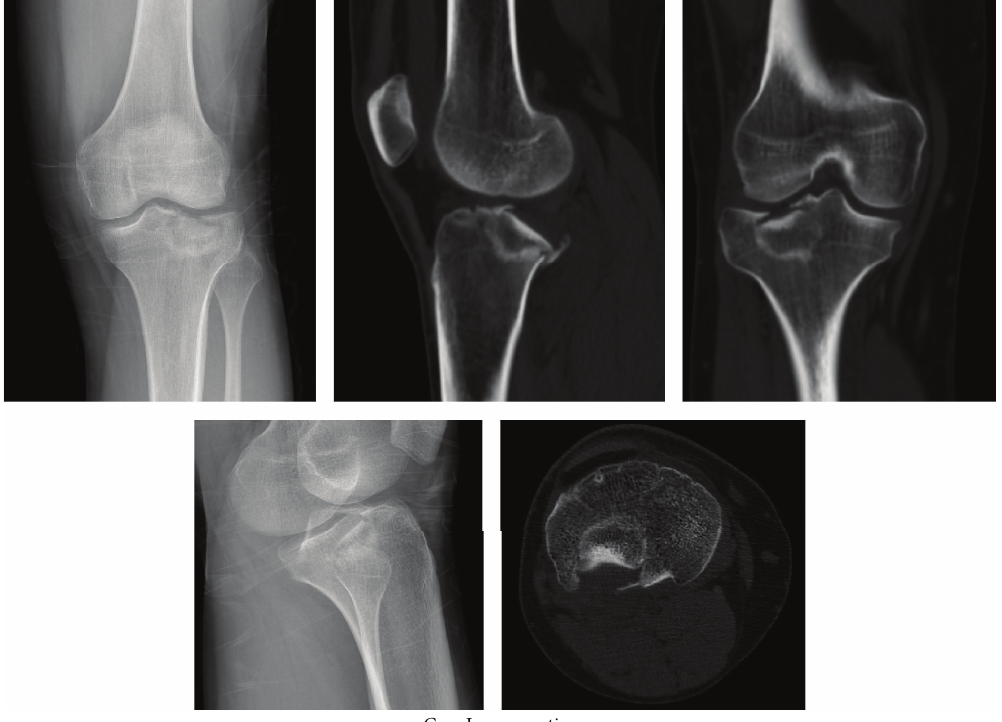
Figure 1: Preoperative radiographies and computed tomography images of Case I.